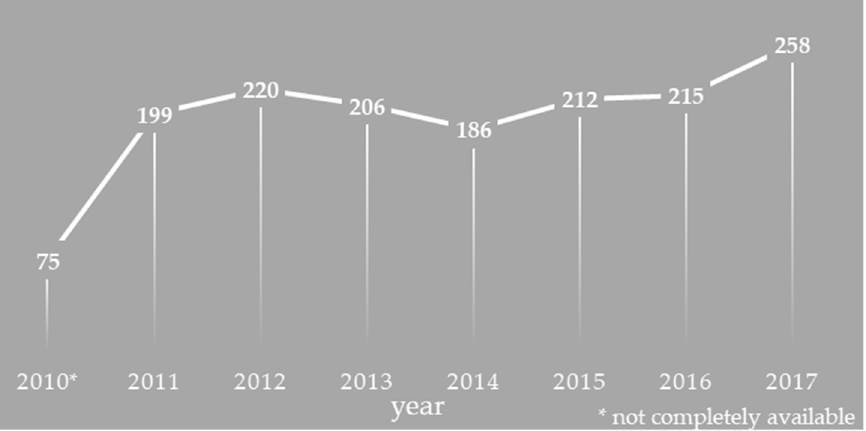
Figure 4. Annual distribution of WVCs (2010–2017).